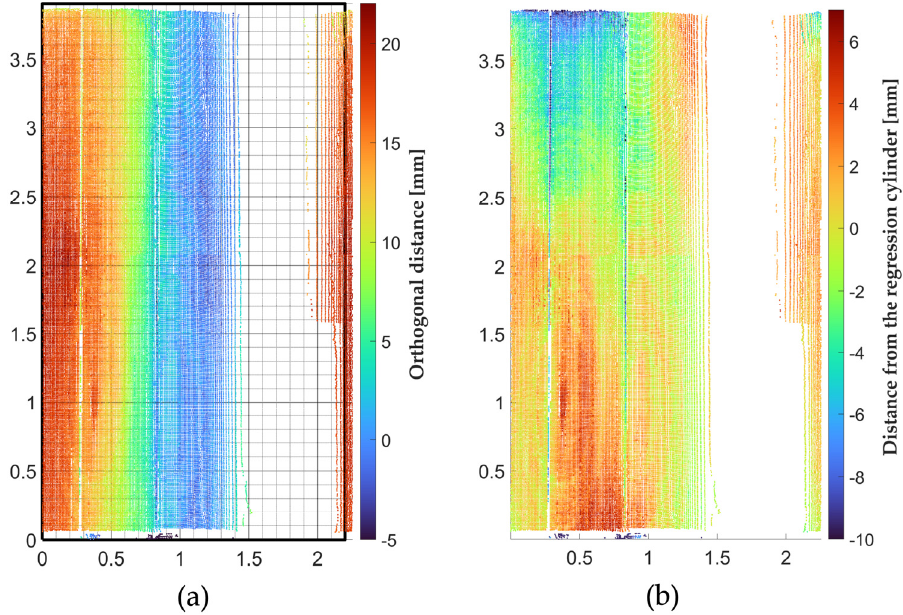
Figure 16. Cylindrical column inspection—column no. 2.: ( a ) BIM vs point cloud; ( b ) surface smoothness